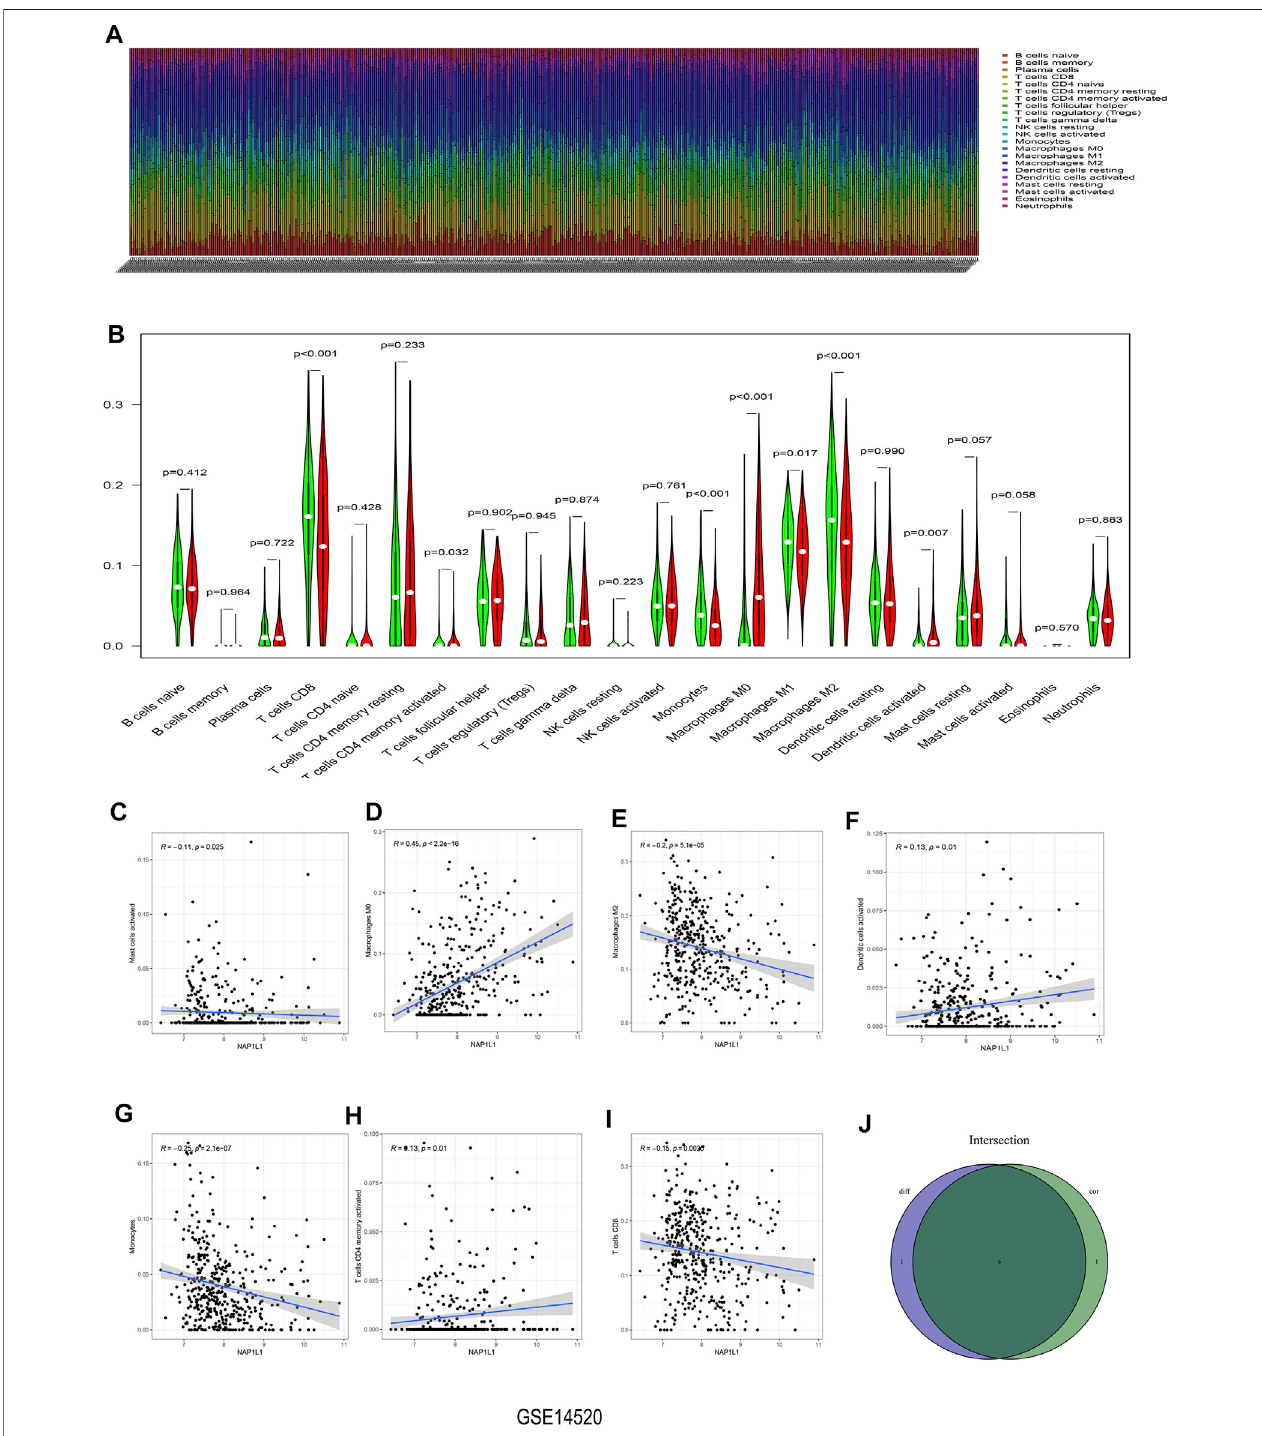
FIGURE 7 | Analysis of immune in fi ltration in the GSE14520 dataset. (A) The bar graph containing the 22 immune cells. (B) The violin graph containing the 22 immunecells. (C) Therelationshipbetween NAP1L1 andactivatedmastcells. (D) Therelationshipbetween NAP1L1 andM0macrophages. (E) Therelationshipbetween NAP1L1 and M2 macrophages (F) The relationship between NAP1L1 and activated dendritic cells. (G) The relationship between NAP1L1 and monocytes. (H) The relationship between NAP1L1 and activated memory CD4Tcells. (I) The relationship between NAP1L1 and CD8 Tcells. (J) The Venn graphwasutilized topicture the meaningful immune cells between the violin plot and the correlation graph.